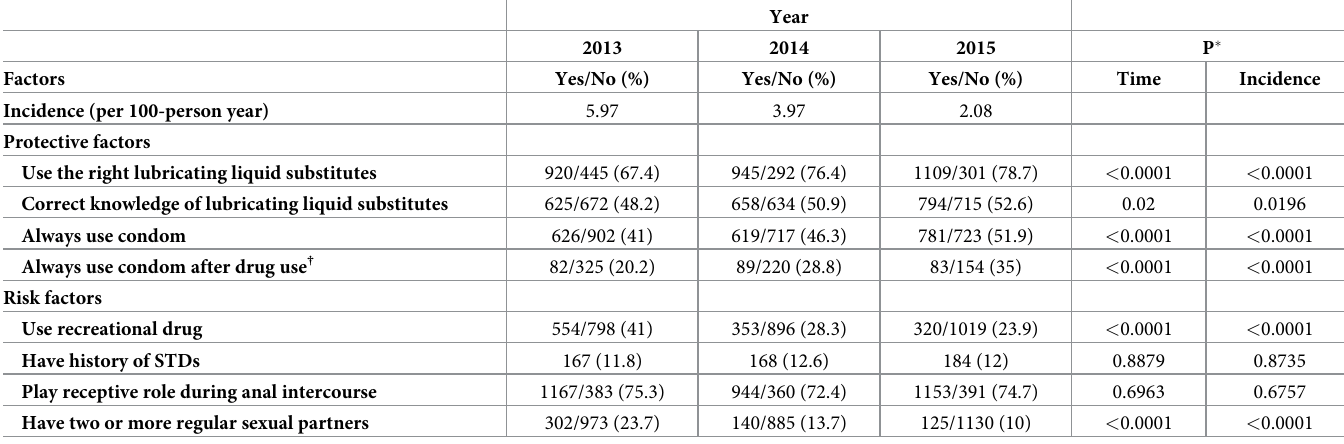
Table 4. Trend analysis of protect factors and risk factors for HIV-1 infection among MSM in Taiwan during